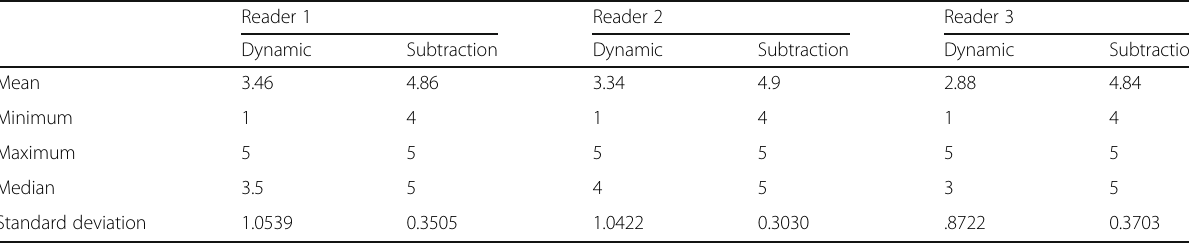
Table 5 Confidence levels among three readers for subtraction and dynamic images Reader 1 Reader